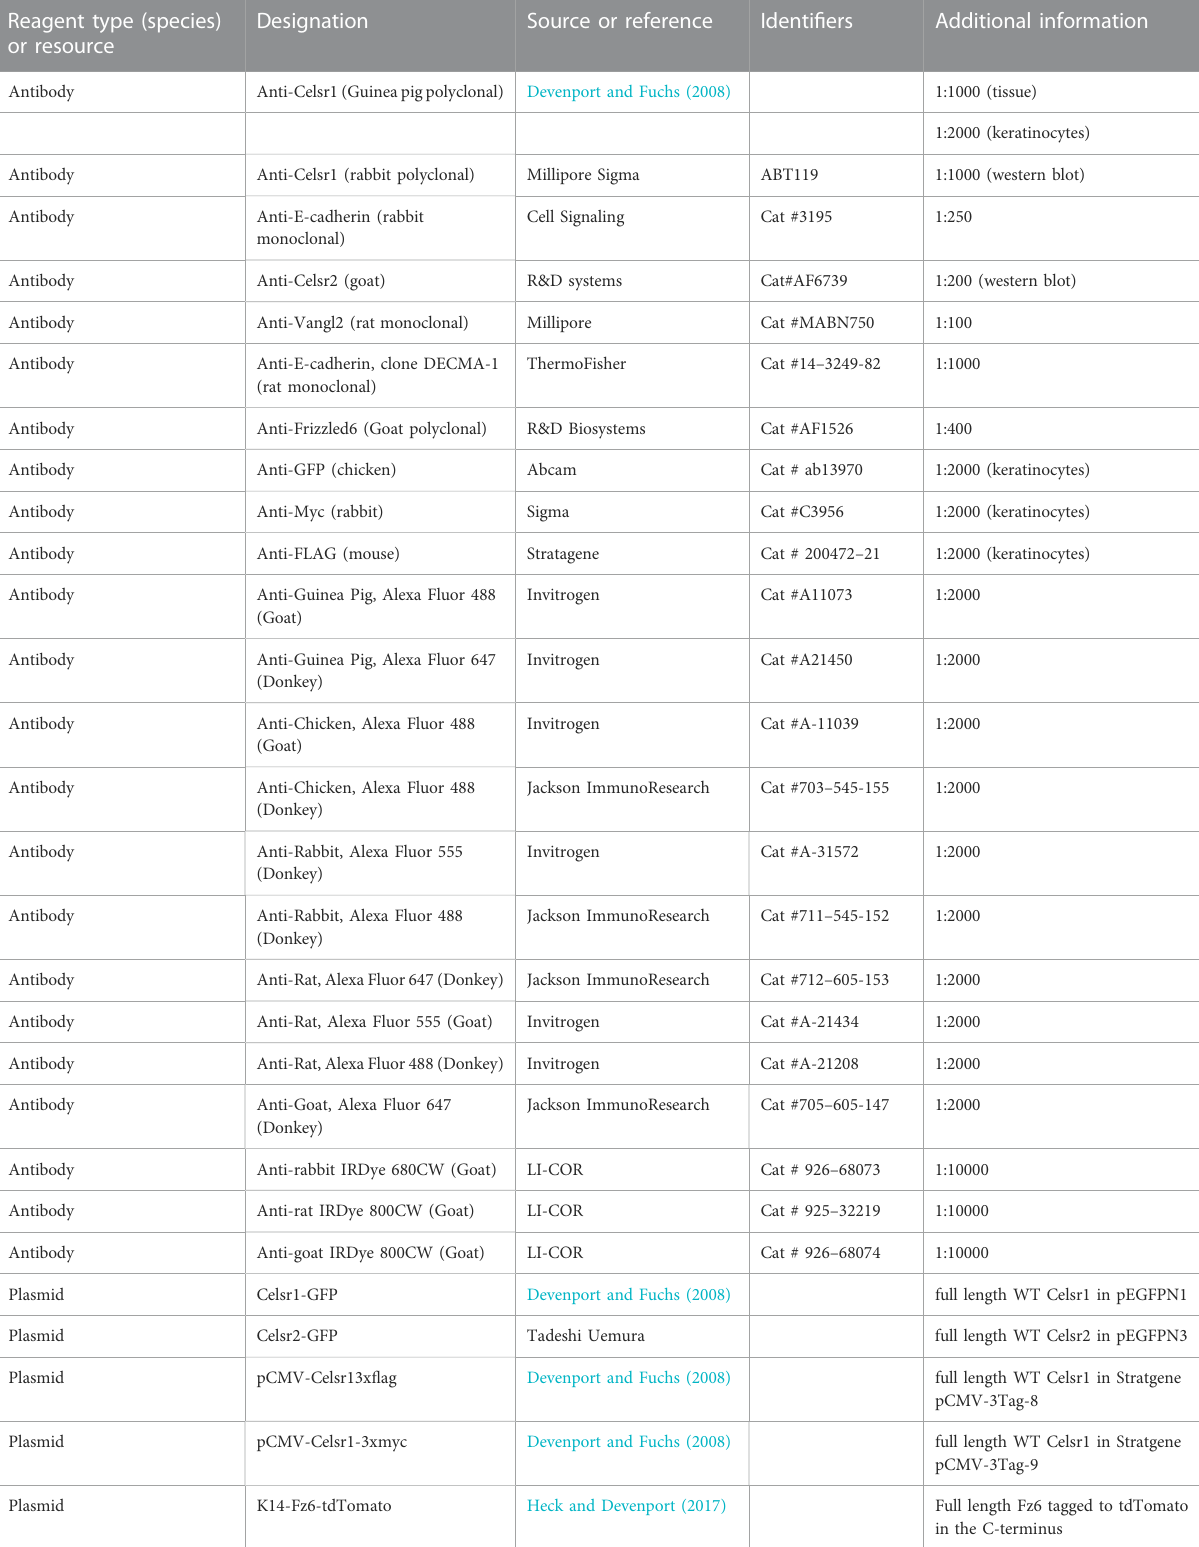
TABLE 2 Genotyping details for Celsr1 and Celsr2 including primer sequences and product sizes for WT and knockout animals. Reagent type (species) or